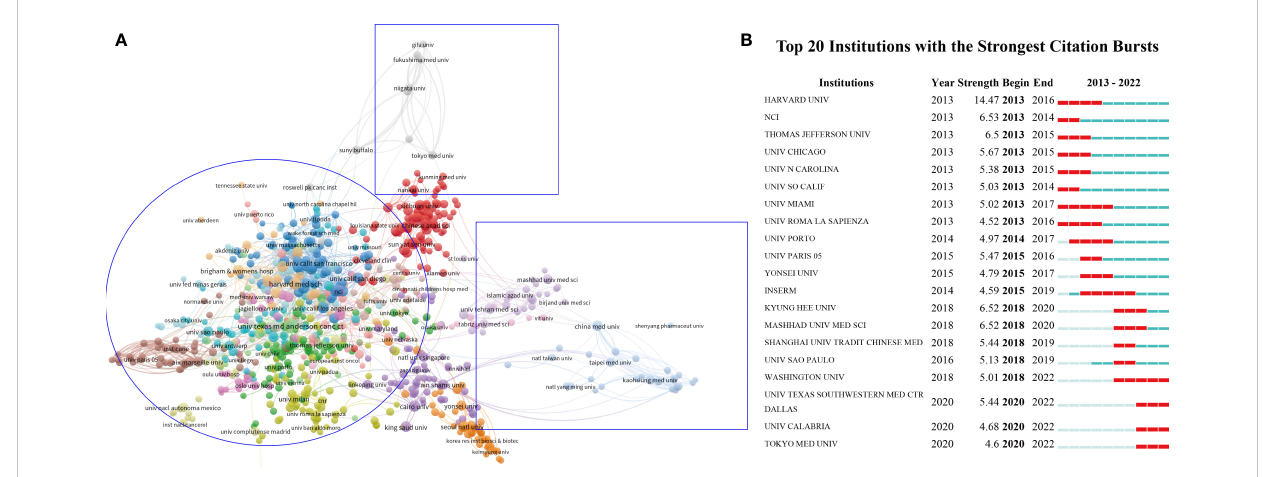
FIGURE 4 (A) The cooperation between different organizations, with blue representing American organizations, red representing Chinese organizations. brown representing France institutions, purple representing the middle east, light yellow representing Britain institutions, yellow representing Italy institutions, grey representing Japan institutions, orange representing Korea institutions and light blue representing rest of Asia institutions. (B) CiteSpace visualization map of top 20 institutions with the strongest citation bursts involved in in fl ammation in breast